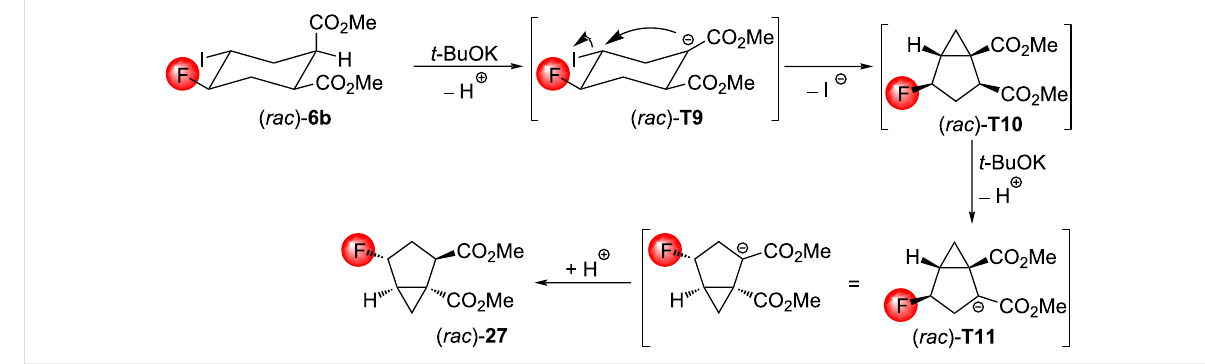
Scheme 17: Presumed mechanism of the reaction of the compound ( rac ) - 6b with t -BuOK.